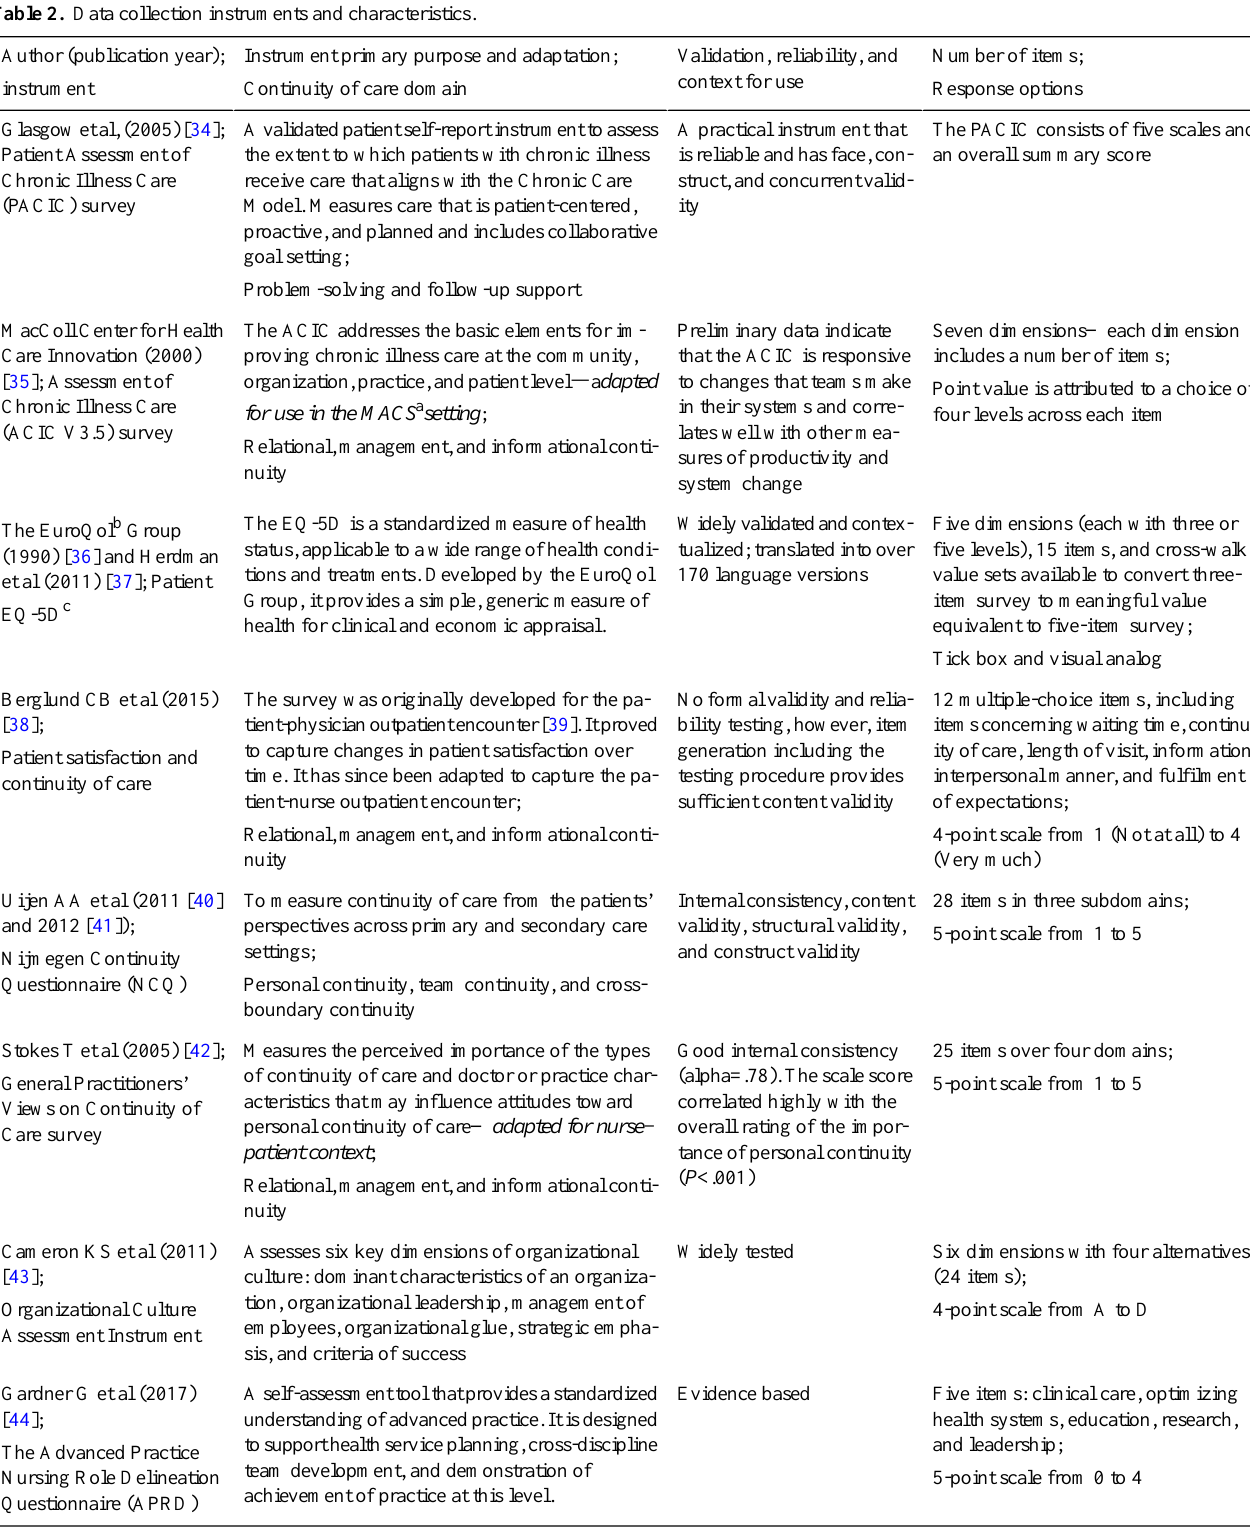
Table 2. Data collection instruments and characteristics.